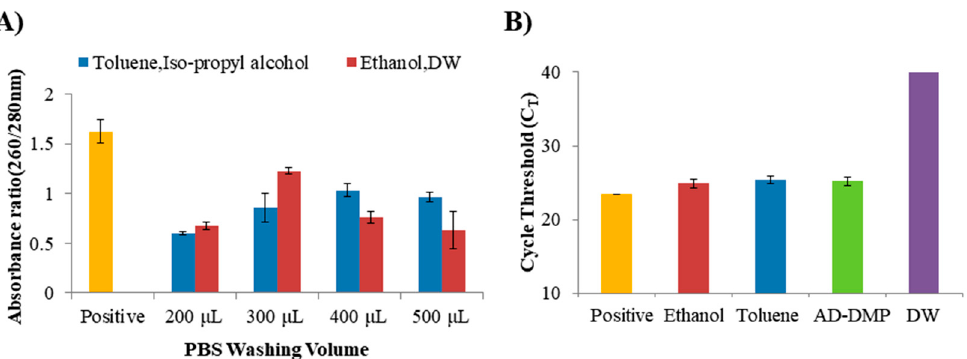
Figure 2. Optimization to compare the efficiency of amine-functional diatomaceous earth (D-AMDPS). ( A ) Results of progressively increasing the PBS washing volume for better nanodrop purity of D-APDMS in two ways (toluene, iso-propyl alcohol or ethanol, distilled water: DW). ( B ) D-APDMS, which was surface-treated in two ways (toluene, iso-propyl alcohol or ethanol, DW), was nucleic acids (NAs) isolated using a conventional research method, and compared with cycle threshold (C T ) values using qPCR, along with samples separated by NAs using the newly applied amount of AD-DMP on the filter plate system. Error bars indicate standard deviation from the mean, based on at least three independent experiments.